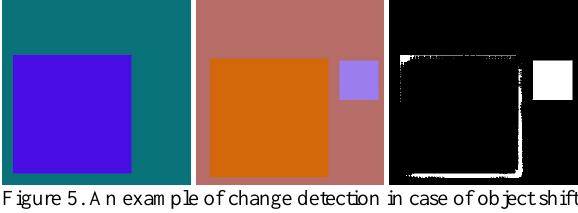
Figure 5. An example of change detection in case of object shift using the network, which was trained on dataset without object shift: left – input image A, middle – input image B, right – synthesized difference map.